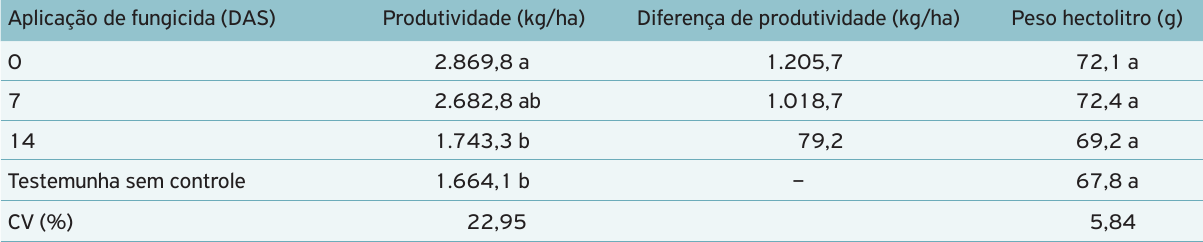
Tabela 3. Produtividade e diferença de produtividade em relação à testemunha sem controle e peso hectolitro, em função de diferentes momentos de aplicação de fungicida para o controle da ferrugem da folha do trigo em Londrina (PR), 2010. Aplicação de fungicida (DAS)